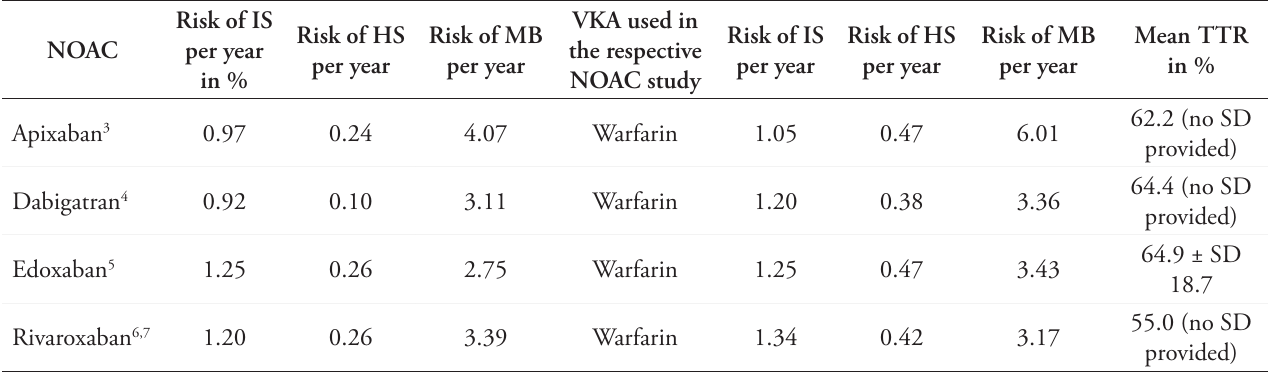
Table 3. Risk of having severe adverse events in the respective NOAC groups and their warfarin controls patients Risk of NOAC